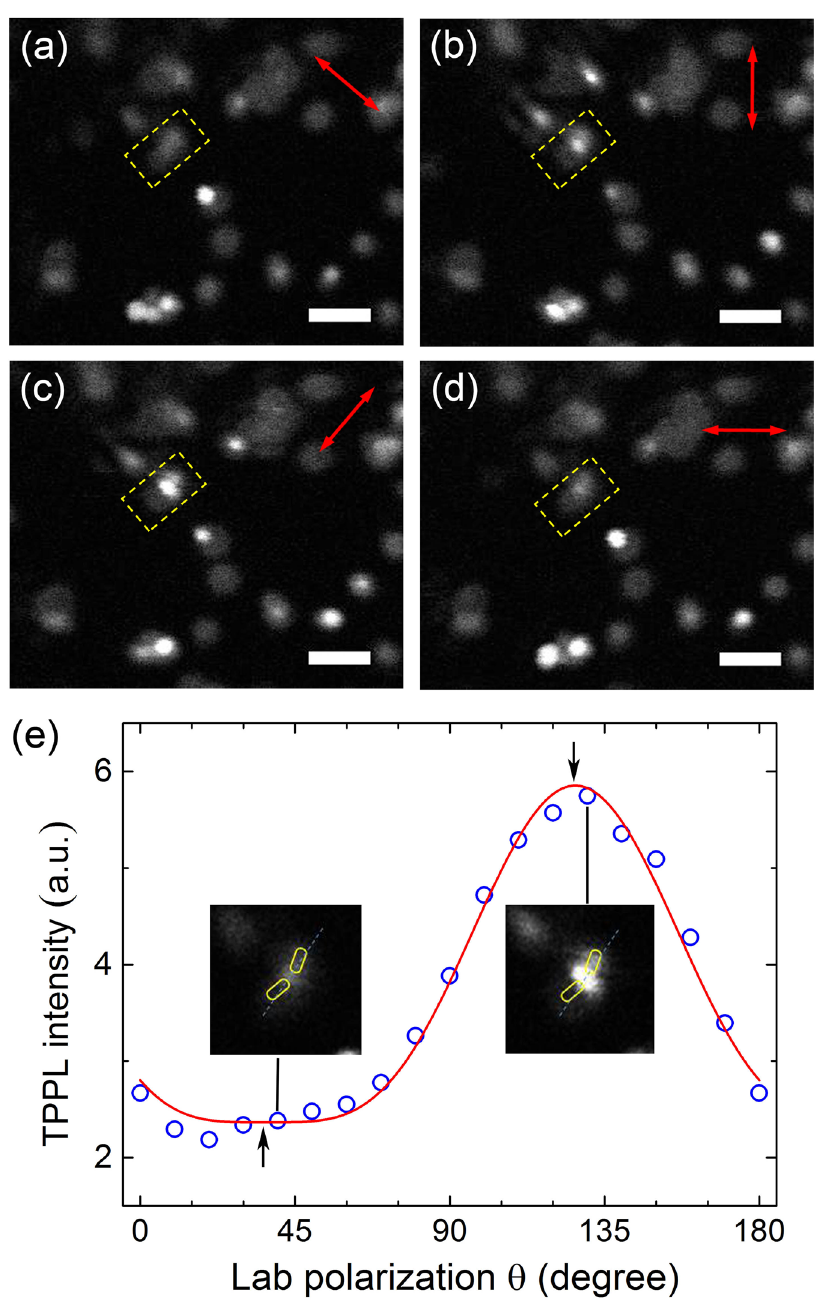
Figure 4. ( a – d ) TPPL images of GNRs imaged through BaTiO 3 microsphere at four representative incident polarisation directions (indicated by red arrows). Yellow outline indicates the region where signal of a nanorod dimer is integrated to plot ( e ). All scale bars: 500 nm. ( e ) Integrated TPPL intensity at different incident polarisations (open dots) with a cos 4 θ curve fitting (solid line). Insets: Corresponding TPPL images close to the fitted maximum and minimum (black arrows), along with the estimated topography of GNR